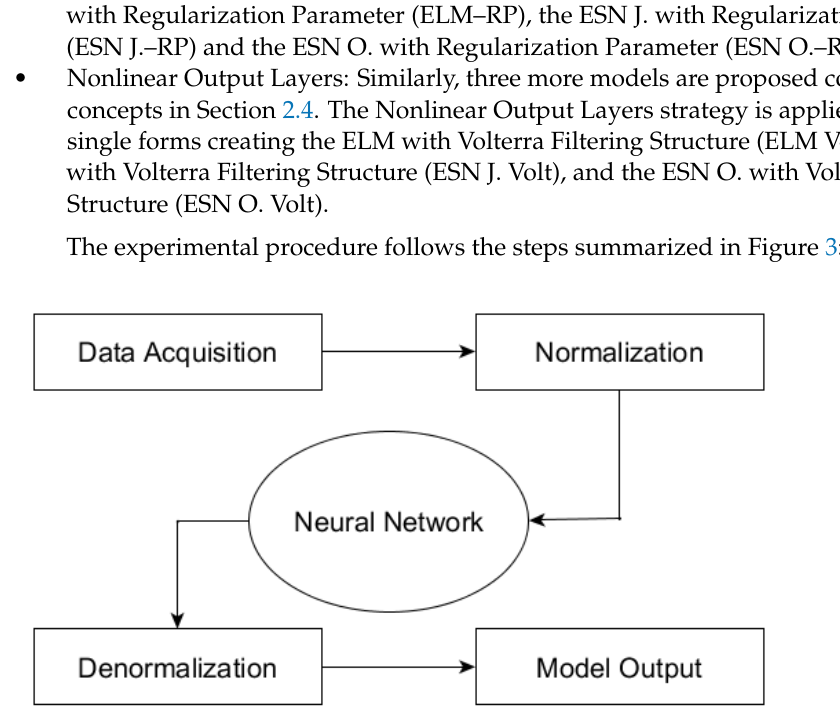
Figure 3. Neural networks appliance